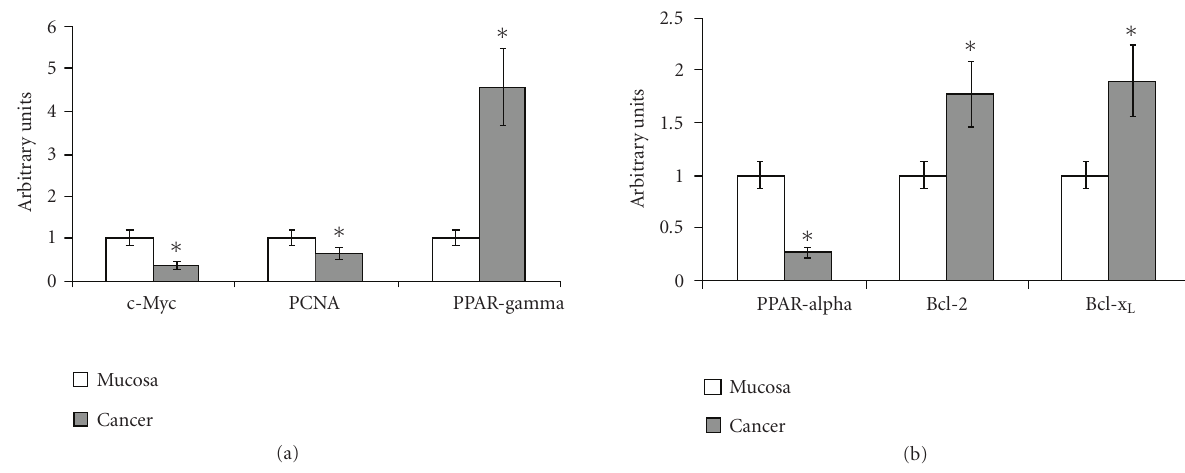
Figure 1: PPAR γ , c-Myc, PCNA, PPAR α , Bcl-2, and Bcl-X L protein contents in colon cancer specimens.Values are means ± SD of 19 patients for PPAR γ , 20 patients for PCNA and c-Myc (a), 21 patients for PPAR α , 13 patients for Bcl-2, and 18 patients for Bcl-X L (b). The densitometry value of each protein for each patient was normalized to the corresponding β -actin value and was expressed as related to that of the corresponding mucosa specimen, set arbitrarily to 1. ∗ t test, colon cancer versus nonneoplastic mucosa ( P < .